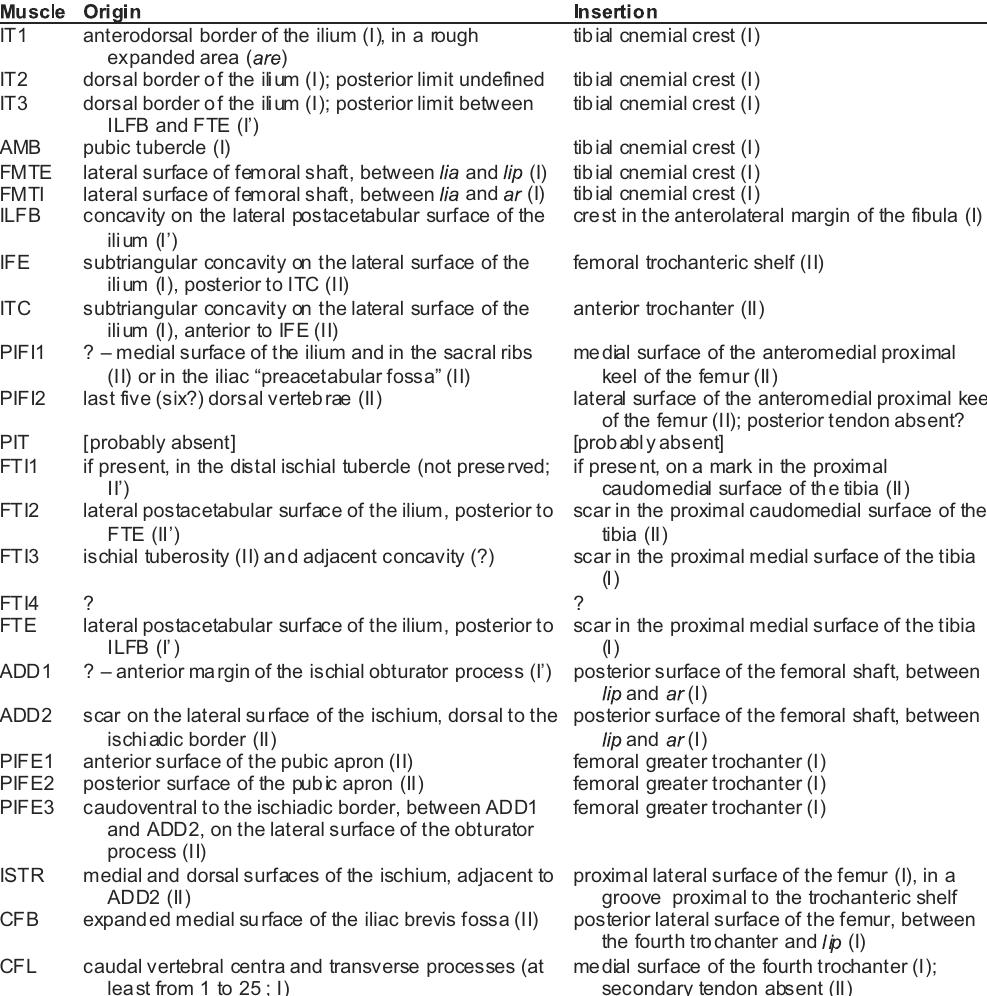
Muscles inferred as present in Staurikosaurus pricei and levels of inference